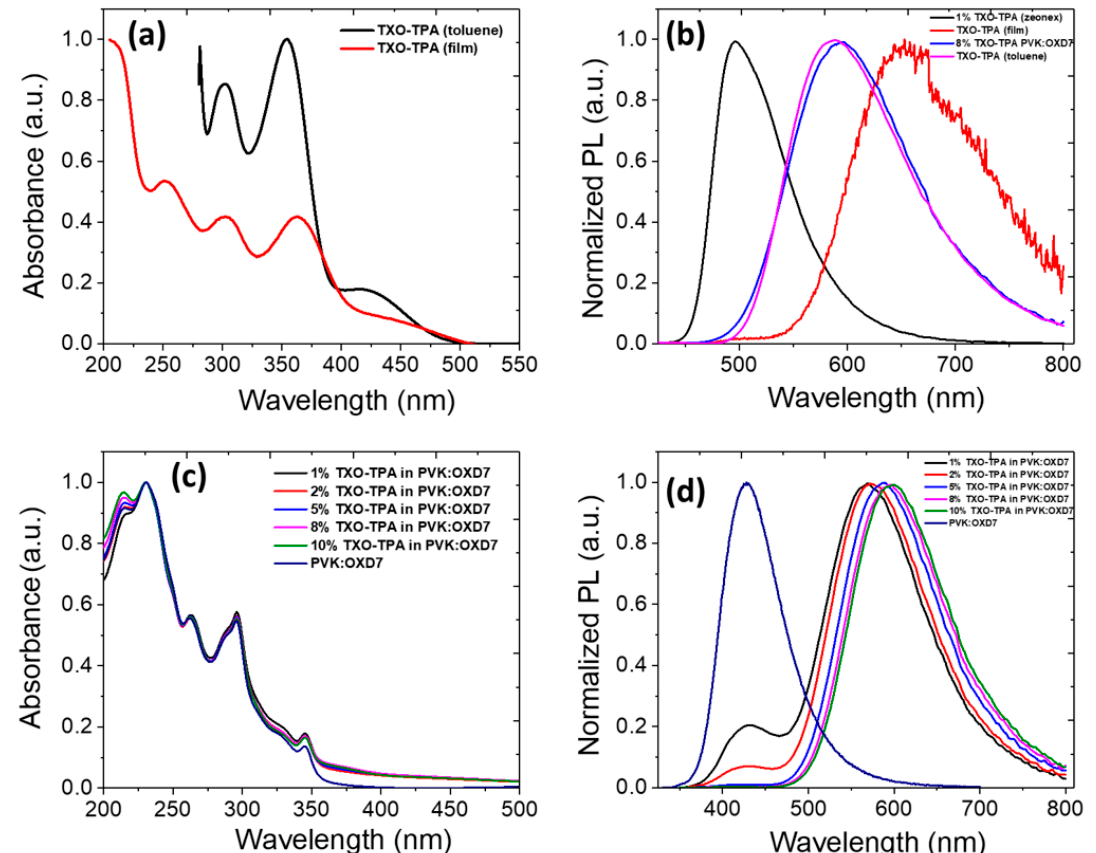
Figure 2. ( a ) Normalized absorption spectra of the TXO-TPA in toluene solution (10 − 5 M) and in